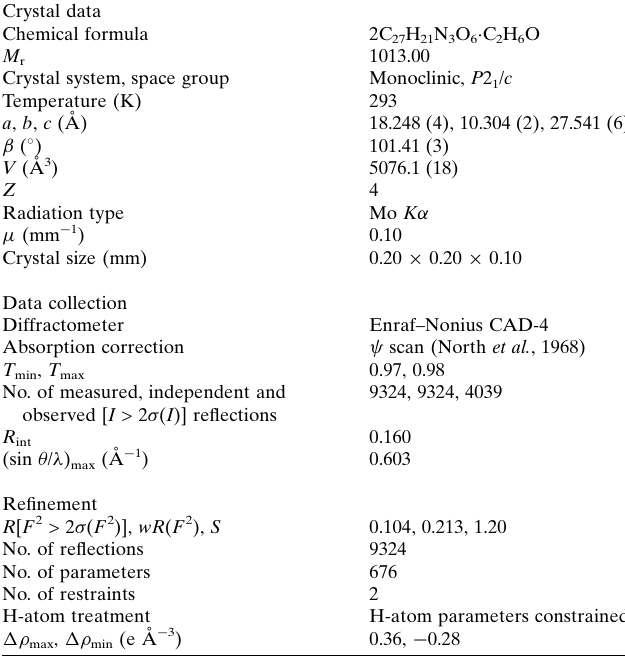
Table 2 Experimental details. Crystal data Chemical formula